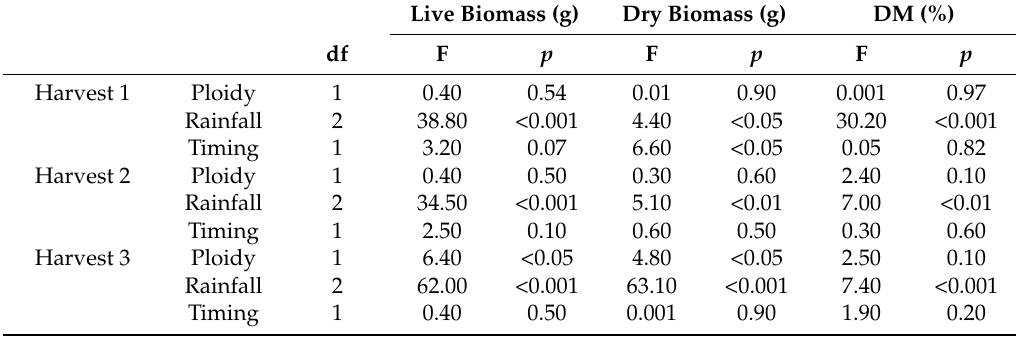
Table 1. ANOVA results for live biomass, dry biomass, and proportion of dry biomass (DM) across each of the monthly harvests. Ploidy, rainfall treatments, and timing were included as potential explanatory variables. Degrees of freedom (df) were equal for all three of the biomass metrics.